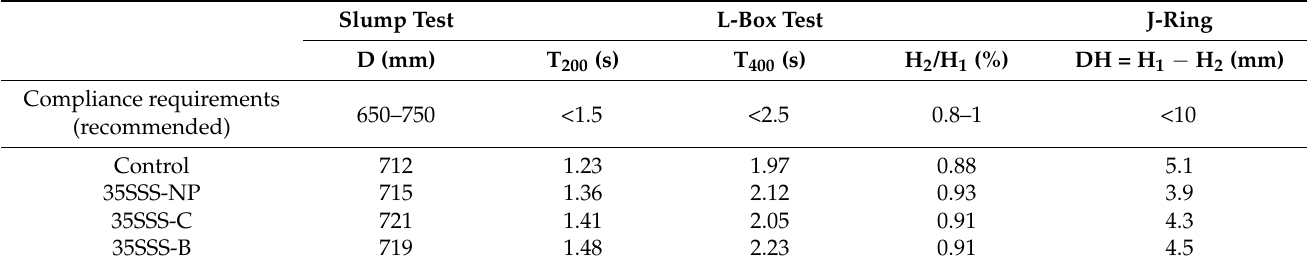
Table 5. Fresh properties of SCC.